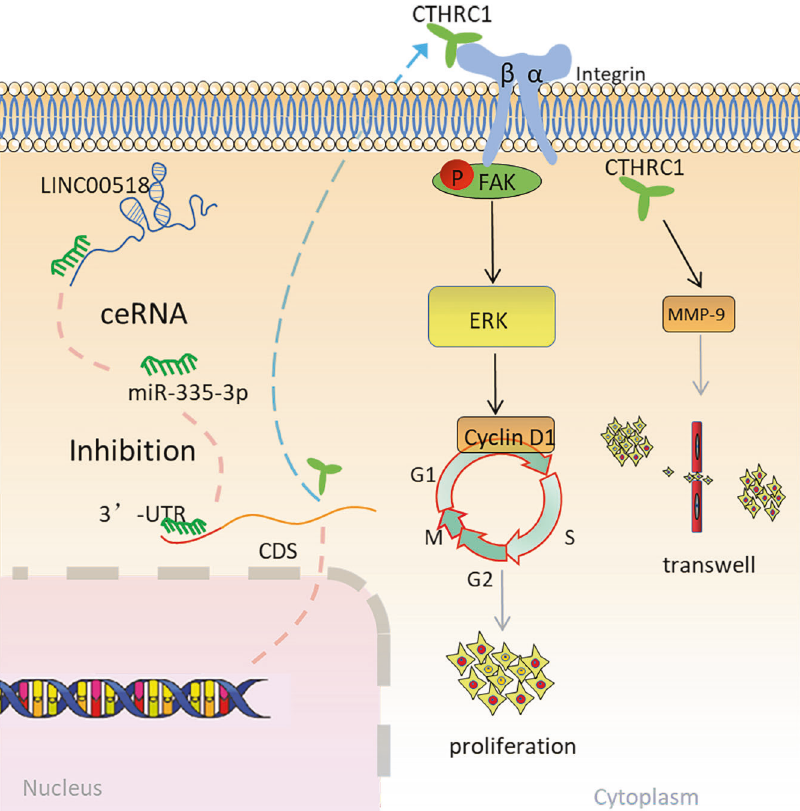
Fig. 8 The model of this study. The model of the LINC00518/miR-335-3p/CTHRC1 axis is in the control of the integrin β 3/FAK signaling